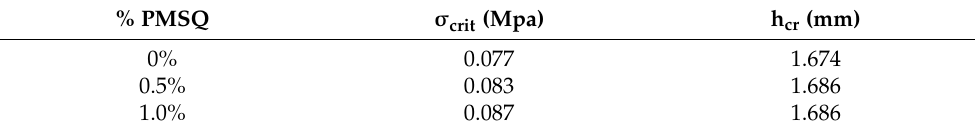
Table 5. Critical values of the von Mises stresses and thickness in the XZ half-plane.